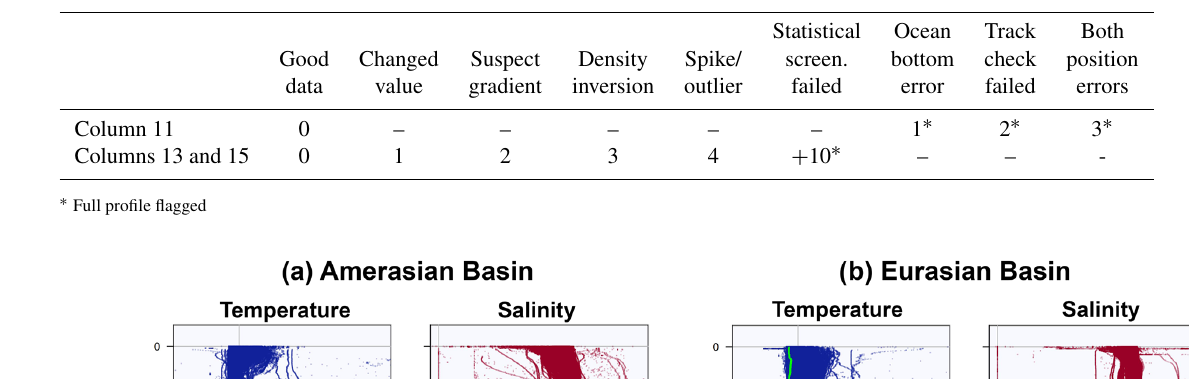
Table 3. Quality flags used to mark erroneous or suspicious data detected during the QC routines.